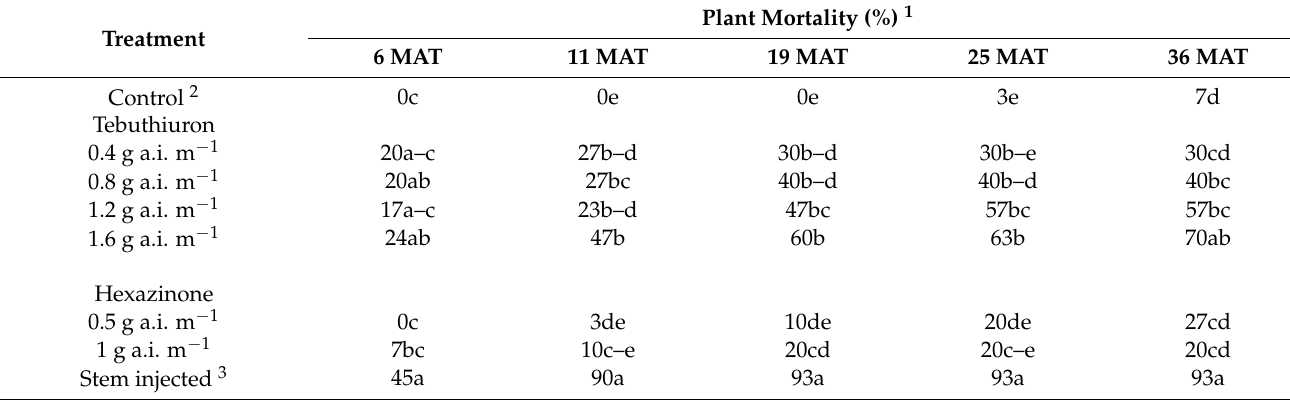
Table 5. Cereus uruguayanus plant mortality 6, 11, 19, 25 and 36 months after treatment (MAT) in response to soil-applied residual herbicides in Experiment 2.